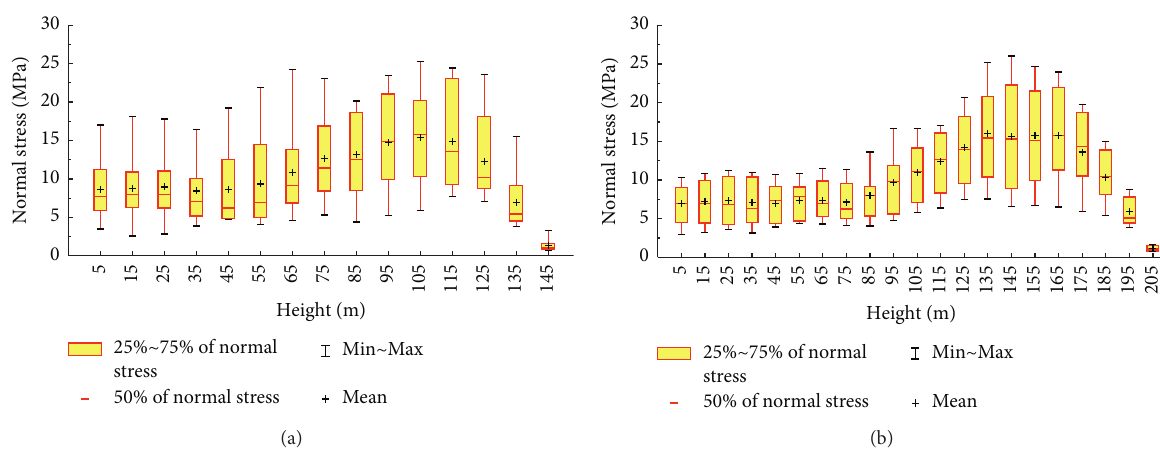
Figure 10: Boxplot of the compressive stress distribution of chimney considering eccentricities: (a) 150m high chimney; (b) 210m high chimney.